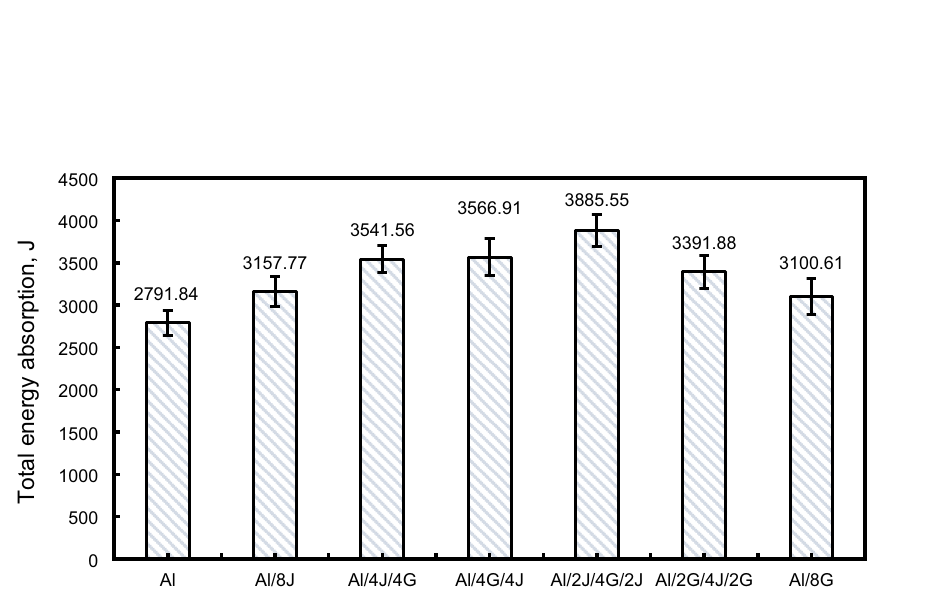
Figure 13. Total energy absorption for tested